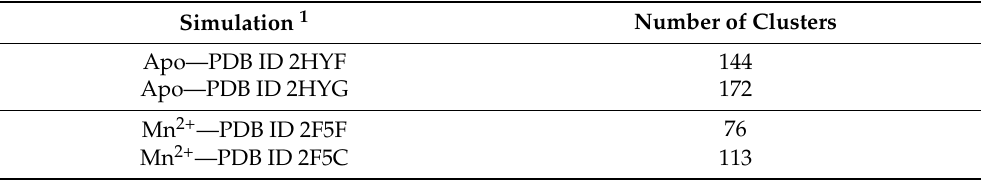
Table 1. Number of clusters found when performing clustering analysis using the gromos algorithm with a cut-off of 1.8 Å on trajectories of apo- and metal-bound MntR